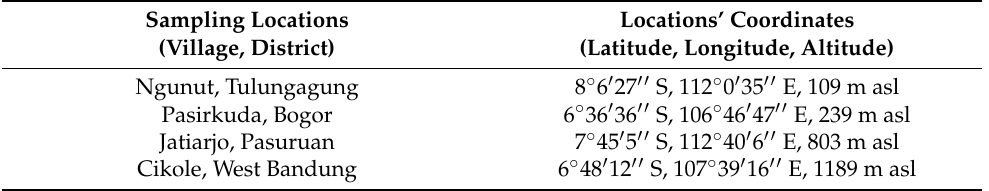
Table 1. Sampling locations for kaffir lime leaves.